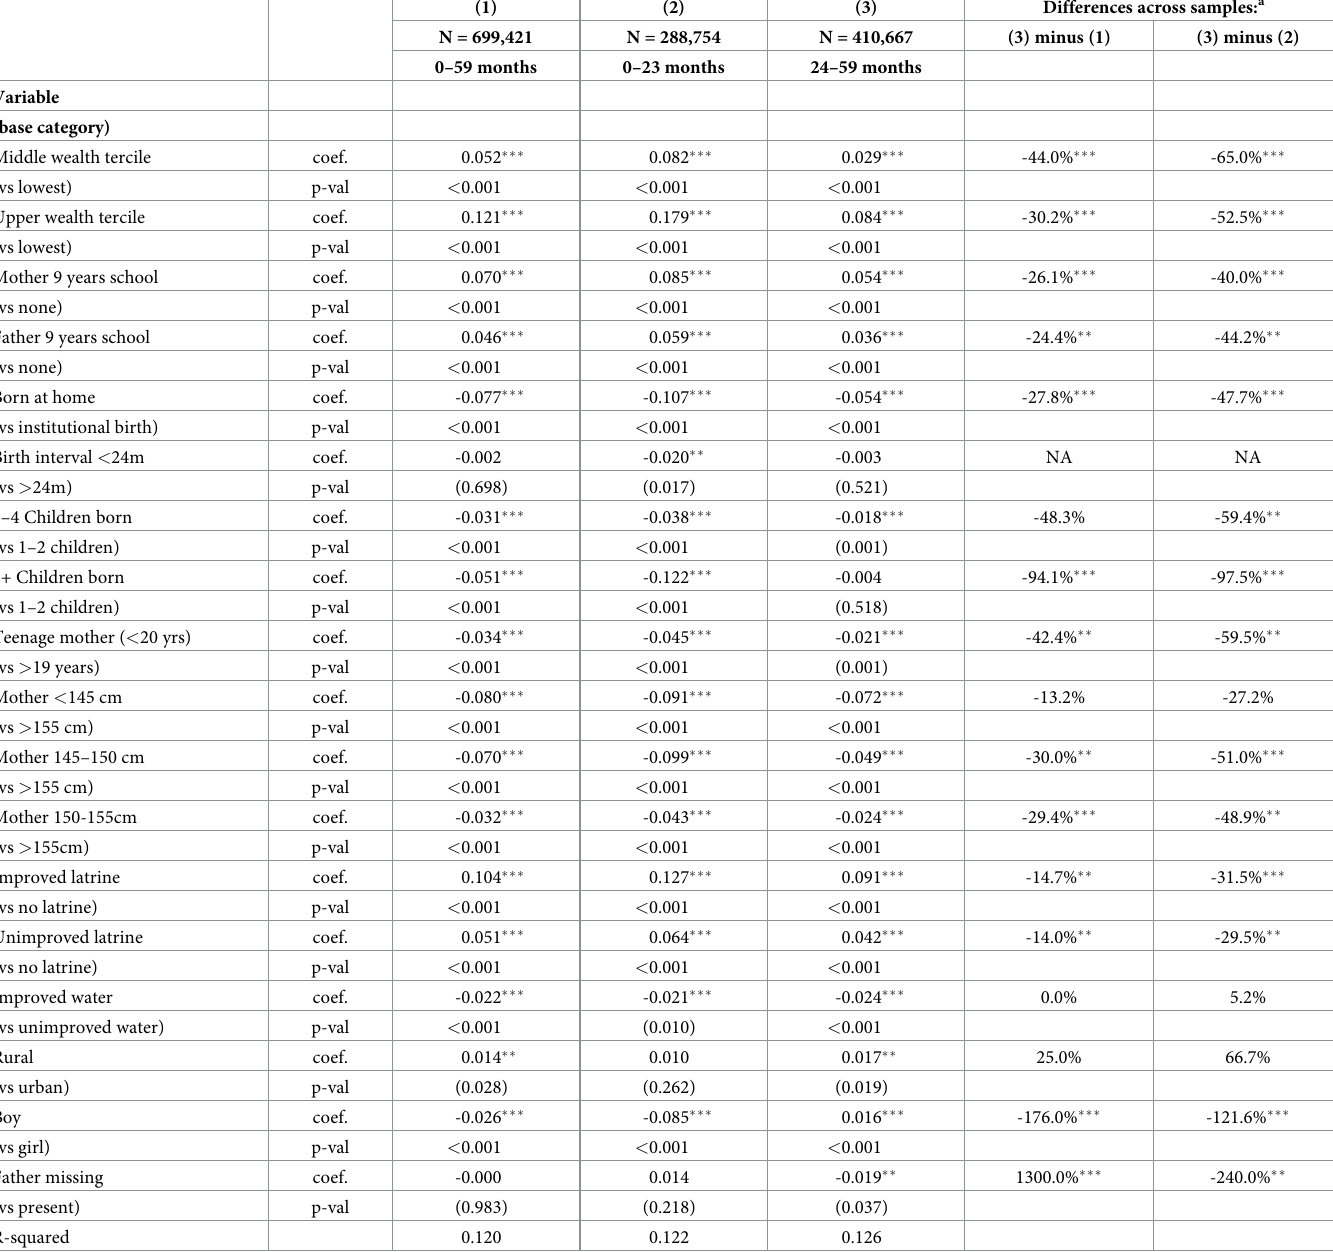
Table 3. Least squares regressions of child WHZ against standard explanatory variables for children aged 0–59 months, 0–23 months and 24–59 months from 57 developing